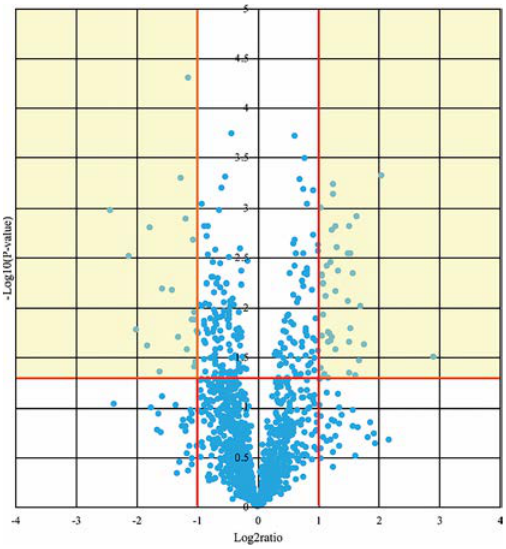
Figure 1 Volcano plot showing the differences in circulating miRNA expression in controls compared with patients with heart failure before cardiac rehabilitation. The x and y axes indicate the signal difference (log 2 ratio) and the level of statistical significance (–log 10 p value), respectively. The vertical red lines correspond to fold changes of 2.0 and 0.5, and the horizontal red line represents a p value of 0.05. The points in the yellow areas represent the miRNAs that met the criteria for significant differential expression.